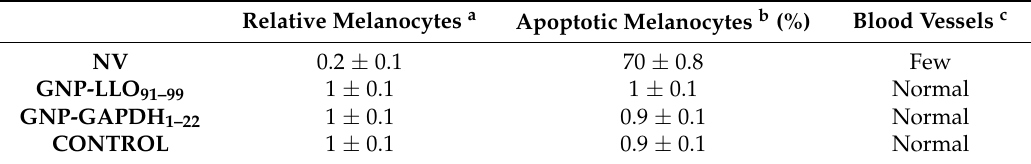
Table 2. Number of relative melanocytes and blood vessels.